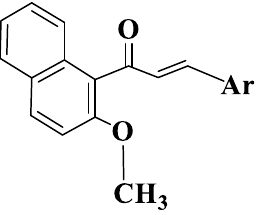
Figure 8. General structure of naphthalenchalcones (compounds 142 – 161 ).